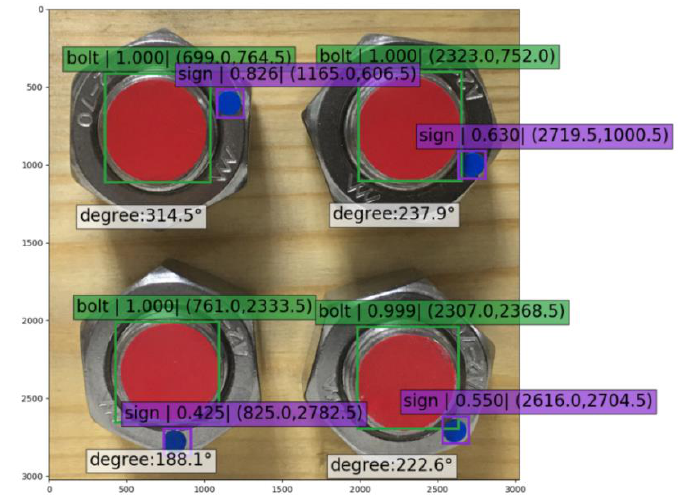
Figure 15. Identification results of a four-bolted connection.